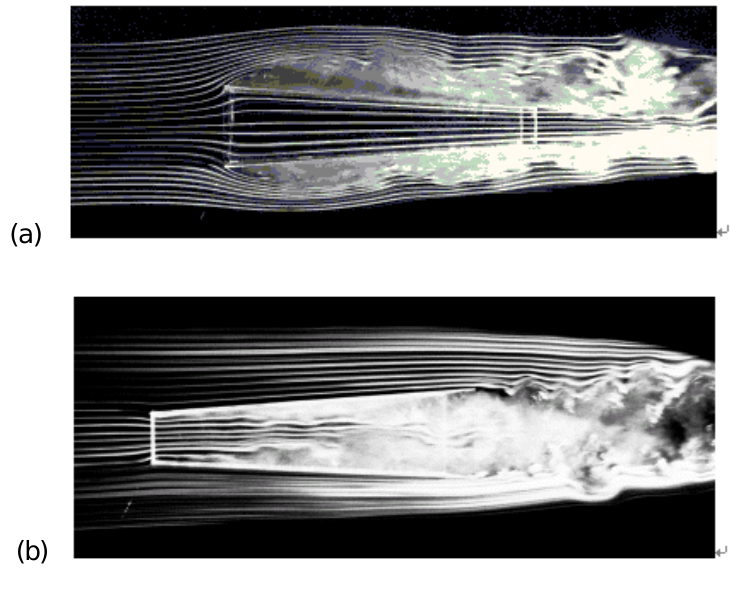
Figure 3. Flows around nozzle- and diffuser-type models. L/D = 7.7. The smoke flows from left to right. (a) Nozzle-type model, (b) Diffuser-type model.